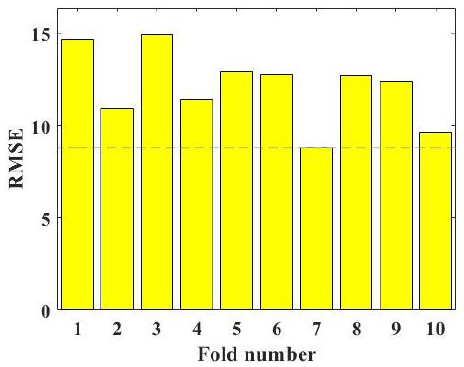
Figure 3. RMSE results of the hyperparameter tuning.